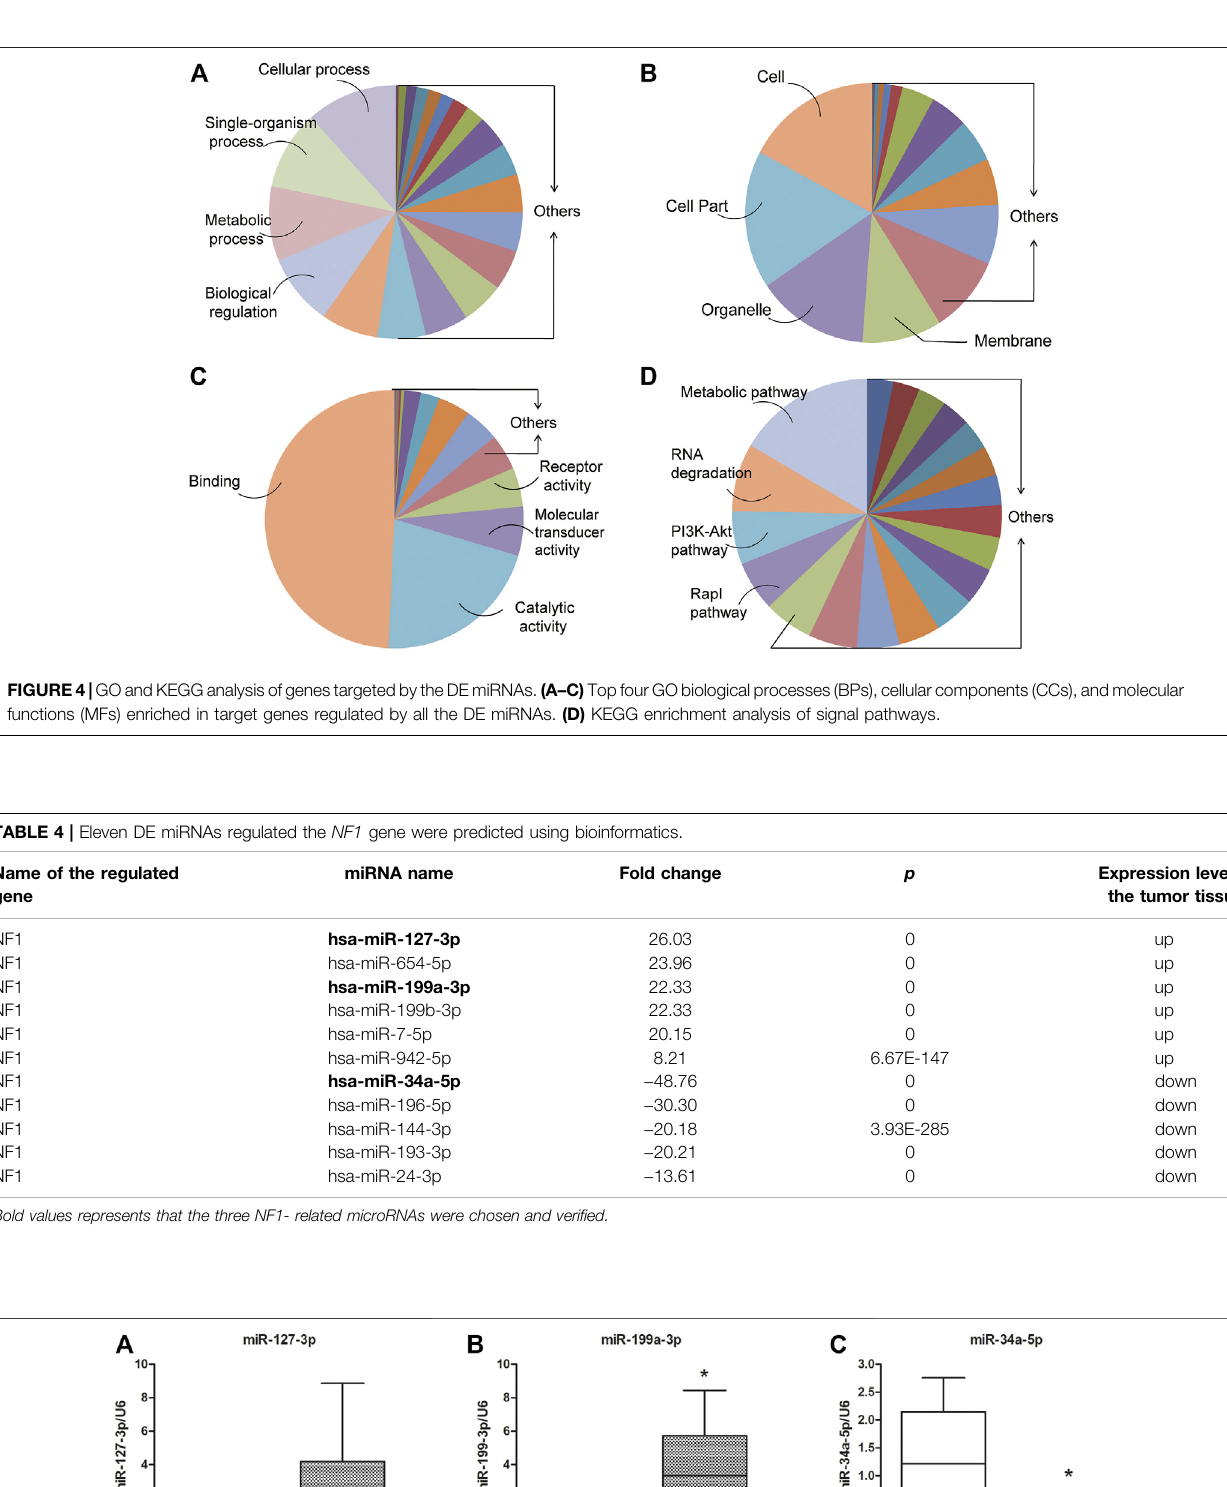
FIGURE 5 | Validation by qRT-PCR of the three miRNAs regulating the NF1 gene. (A – C) were the expression and comparison of miR-127-3p, miR-199a-3p, and miR-34a-5p in 68 pairs of the UPS tumor tissue and adjacent normal tissue. U6 was used as the reference gene. *: vs. adjacent normal tissue, p < 0.05.